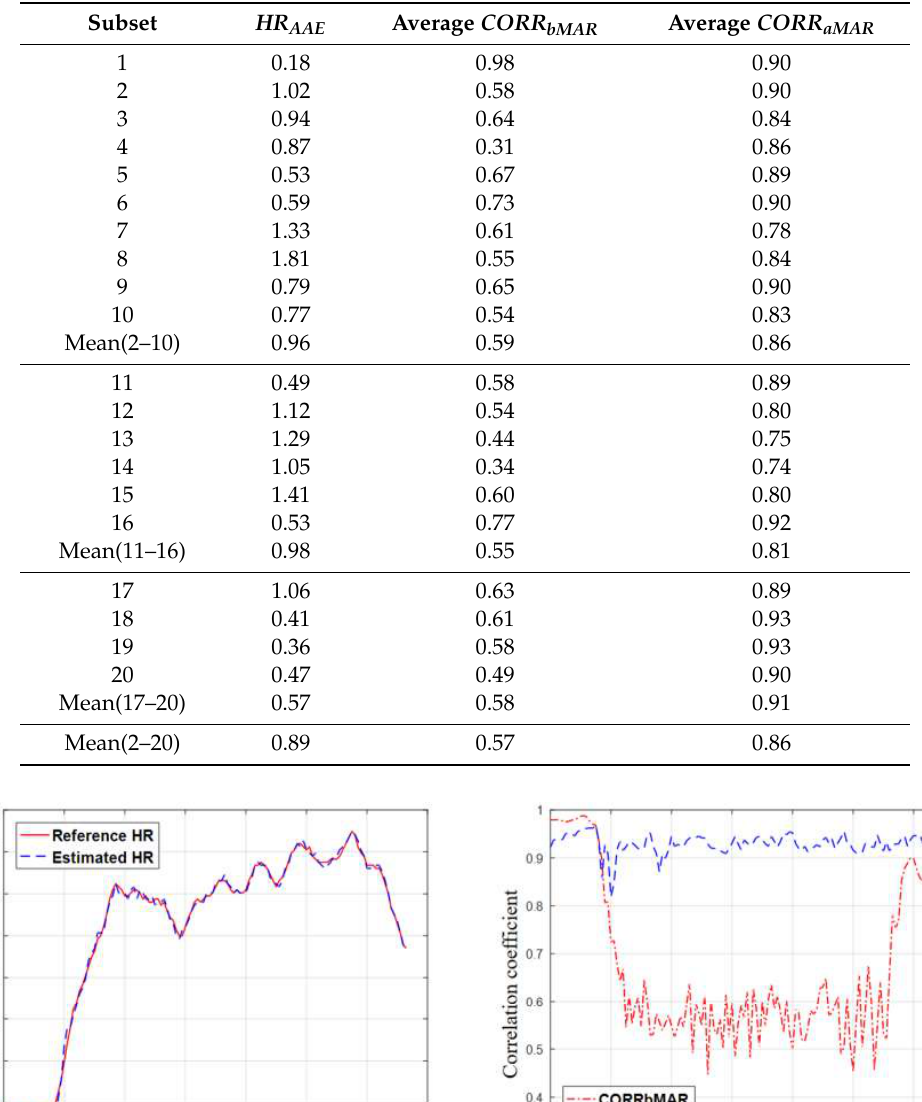
Table 6. Experimental results for the 20 data subsets of the self-built data set.